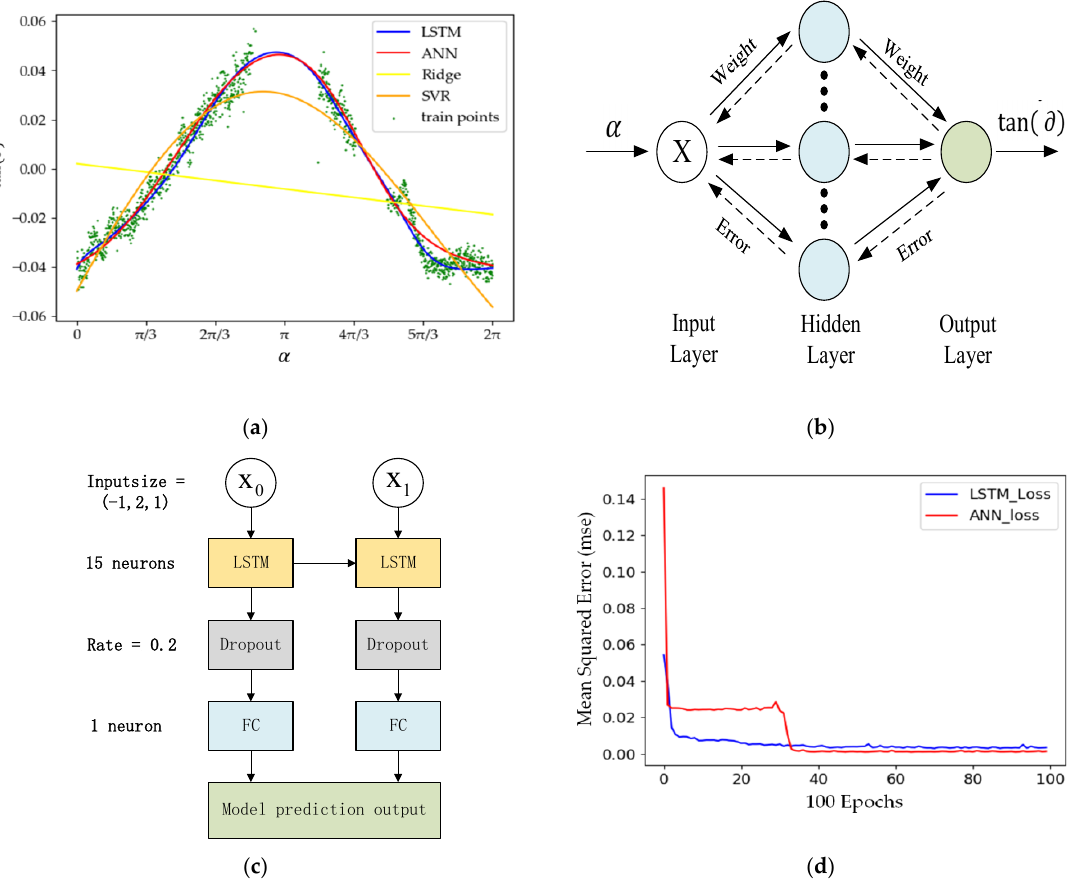
Figure 13. The inclination angle between the BGP and the projection plane obtained by the machine learning model. ( a ) The fitting results of the tan(𝜕) curve by different machine learning models. ( b ) The schematic diagram of a backpropagation artificial neuron network (BP-ANN) machine learning model. ( c ) The schematic diagram of a long short-term memory (LSTM) machine learning model; ( d ) The loss curves generated by the mean square error function with the LSTM model and BP-ANN mode.